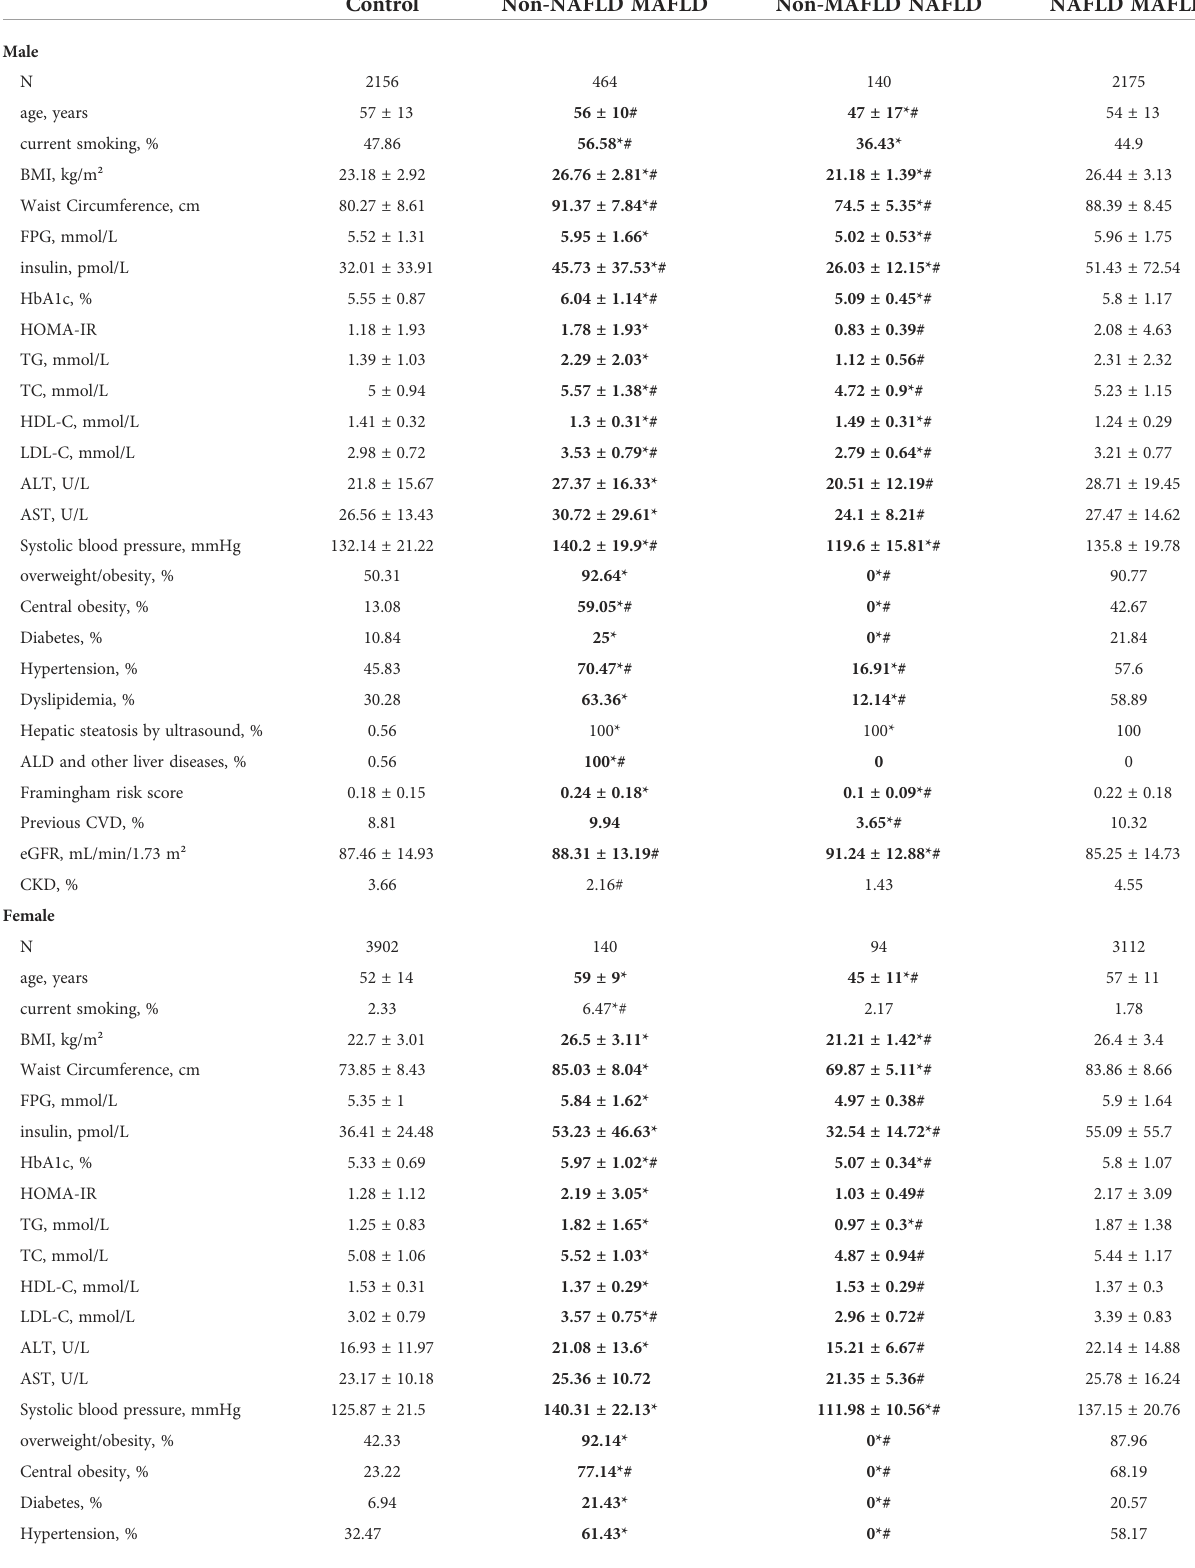
TABLE 2 Clinical characteristics of participants with and without MAFLD and NAFLD.